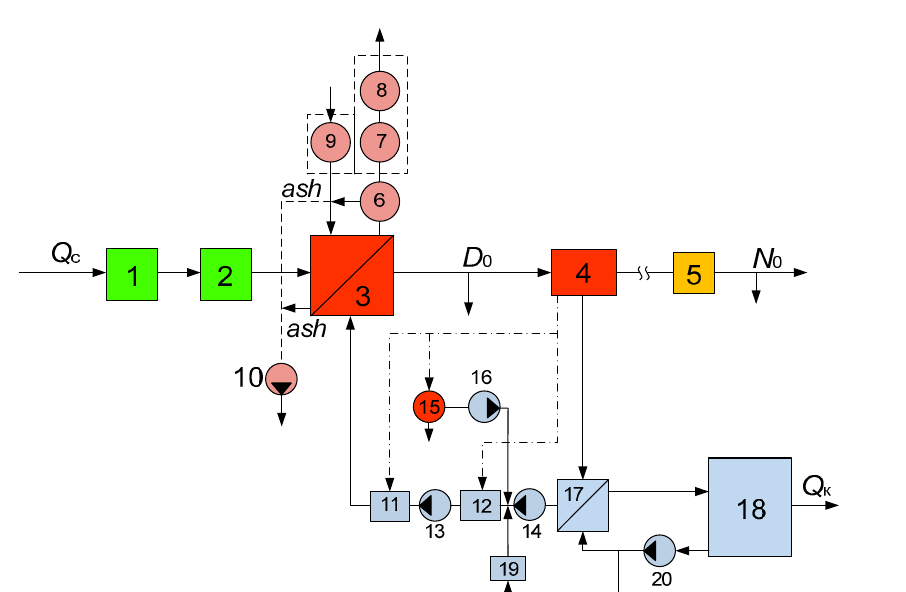
Figure 5. Basic technological scheme of a thermal power station: 1—fuel storage; 2—fuel preparation; 3—steam boiler; 4—steam turbine; 5—electric generator; 6—ash catcher; 7—smoke exhauster; 8—chimney; 9—blower fan; 10—ash removal; 11—high-pressure heater; 12—low-pressure heater; 13—pump; 14—condensate pump; 15—heat consumer; 16—return condensate pump; 17—condenser; 18—technical water supply; 19—chemical water treatment; 20—cooling water pump; Q c —fuel heat consumption per station; Q к — heat loss with cooling water; D 0 —steam flow to the turbine; N 0 —electrical power transmitted to consumers.